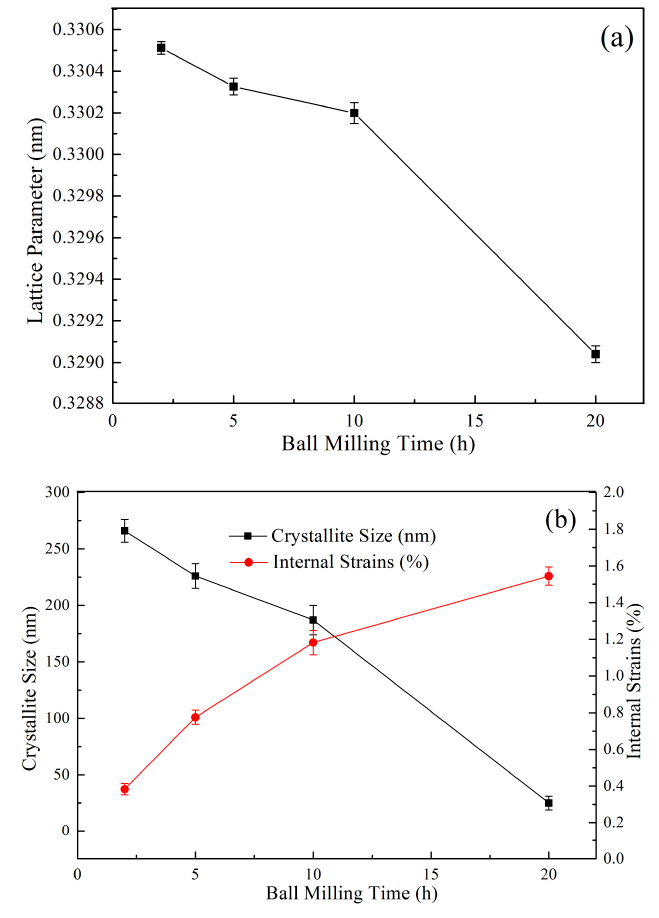
Figure 5. Evolution of the ( a ) lattice parameter; ( b ) crystallite size and internal strain of Nbss grains with ball milling time, calculated based on the XRD data. Metals 2018 , 8 , x FOR PEER REVIEW In order to further confirm the XRD results and reveal the microstructure change of powder particles during ball milling, TEM analysis was carried out on the powders after ball milling for 20 h and 40 h, respectively. Figure 6a–c show the BF-TEM (bright field TEM) images, the corresponding selected area electron diffraction (SAED) image and HRTEM (high-resolution TEM) image, respectively, of the powders after ball milling for 20 h. The diffraction patterns obtained by fast Fourier transform (FFT) in different regions of HRTEM image are inserted in Figure 6c, as shown in Figure 6(c1,c2). The fine grains with typical characteristics of as-milled particles are displayed in the BF-TEM image (Figure 6a). The SAED pattern (Figure 6b) clearly demonstrates the polycrystalline characteristics of the powders. The diffraction rings of the Nb (110), (200), (211), (220), (310), (222), and (321) crystal planes are apparent. However, no diffraction rings or spots of other elements, such as Ti, Si, or Cr, are found, which further verifies that the supersaturated Nbss are formed in the